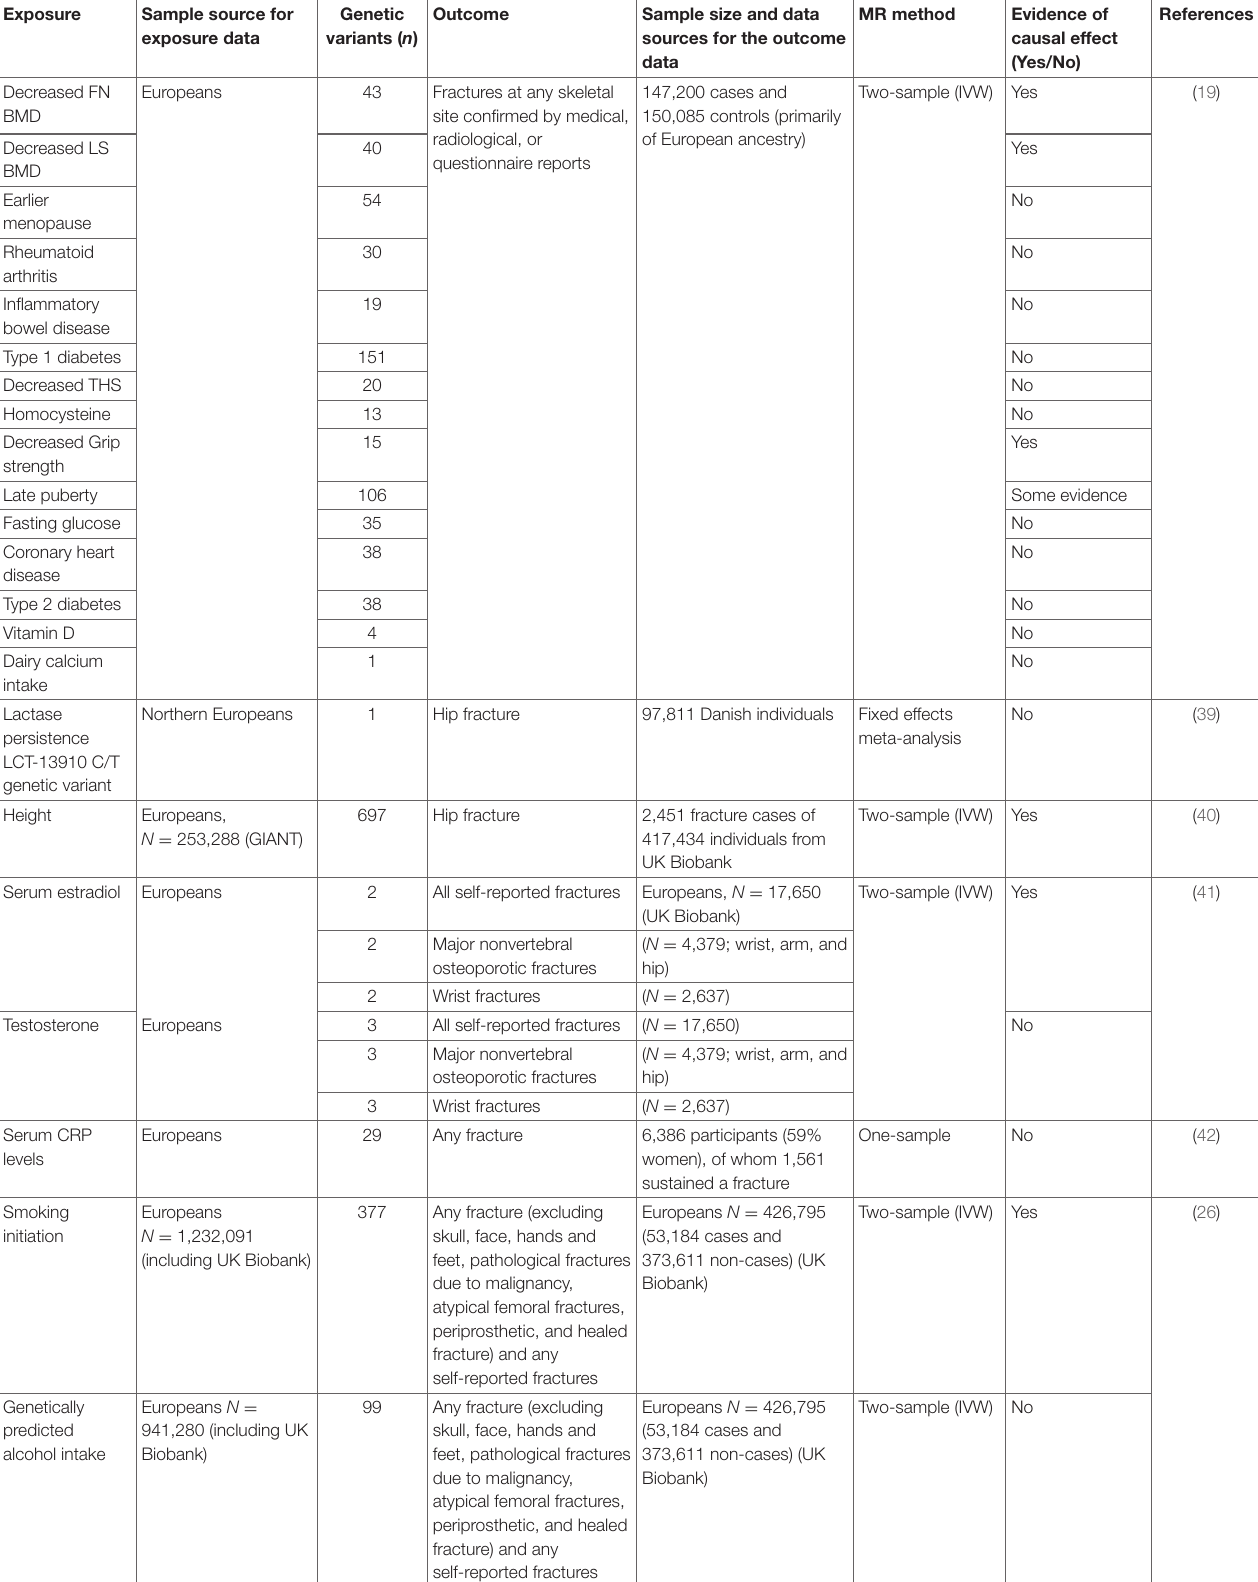
TABLE 2 | Examples of MR studies using fracture as an outcome.